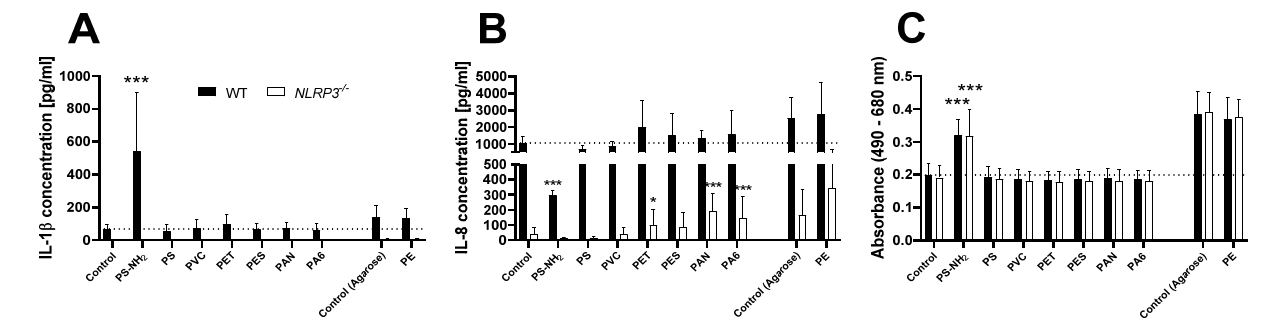
Figure 6. Release of IL-1 β ( A ) and IL-8 ( B ), as well as LDH activity ( C ) in the supernatant of PMA- differentiated THP-1 WT (full bars) or NLRP3 − / − (open bars) cells after 24 h treatment with 50 µg/cm 2 of different plastic particles. Cytokine data is depicted as relative values compared to the WT control, LDH data is depicted as relative values compared to the respective control. Mean ± SD of N = 4, * p < 0.05 and *** p < 0.001 compared to the respective control.